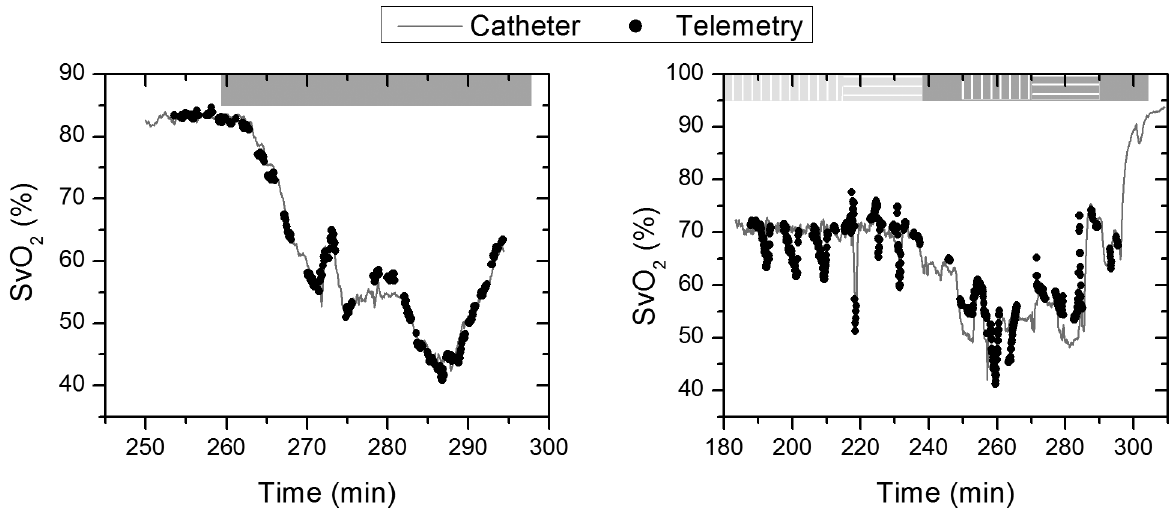
Figure 6. Venous oxygen saturation. Data from the telemetry sensor (black dots) and the central venous catheter (grey line) for study 1 (left) and 2